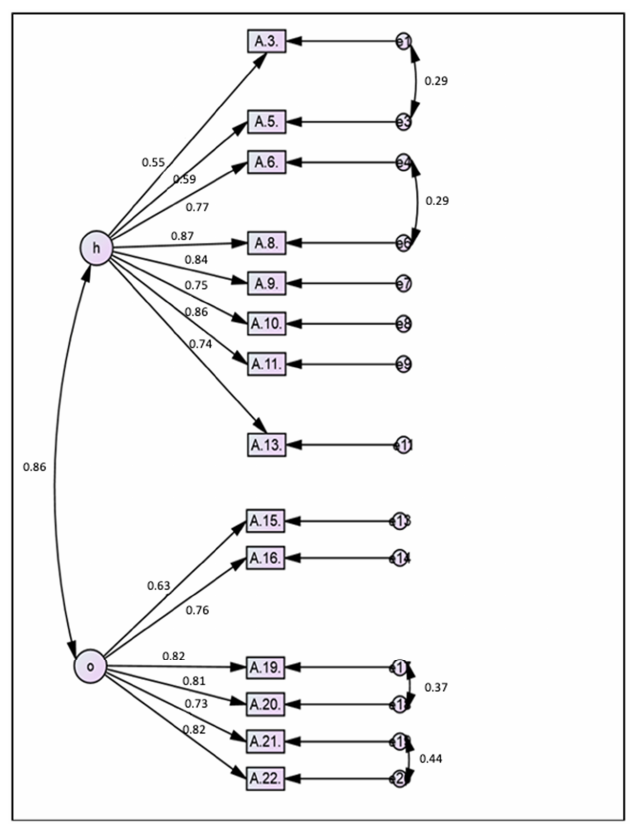
Figure 2. Final model of the AAAQ containing 14 items